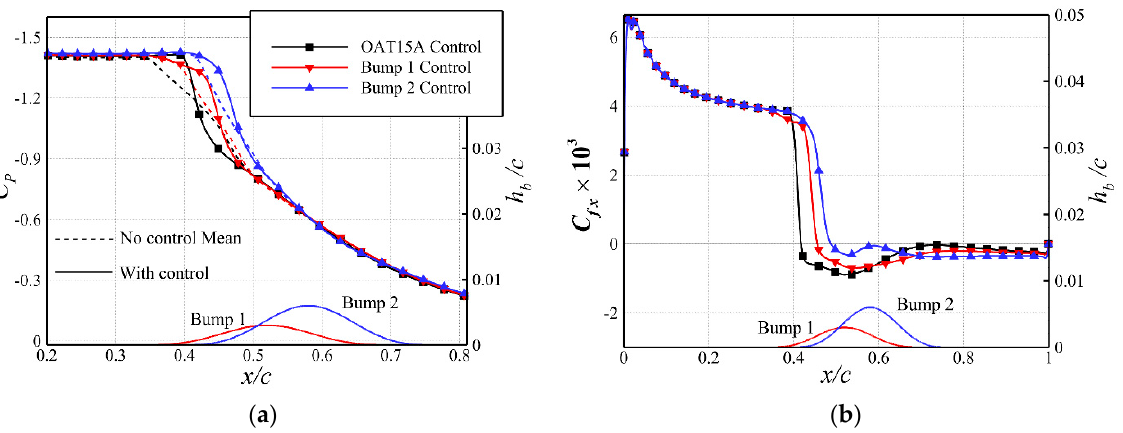
Figure 14. Comparison of 𝑪 𝒑 and 𝑪 𝒇𝒙 distributions in steady state for different configurations. ( a ) Pressure coefficient. ( b ) x -component of skin friction